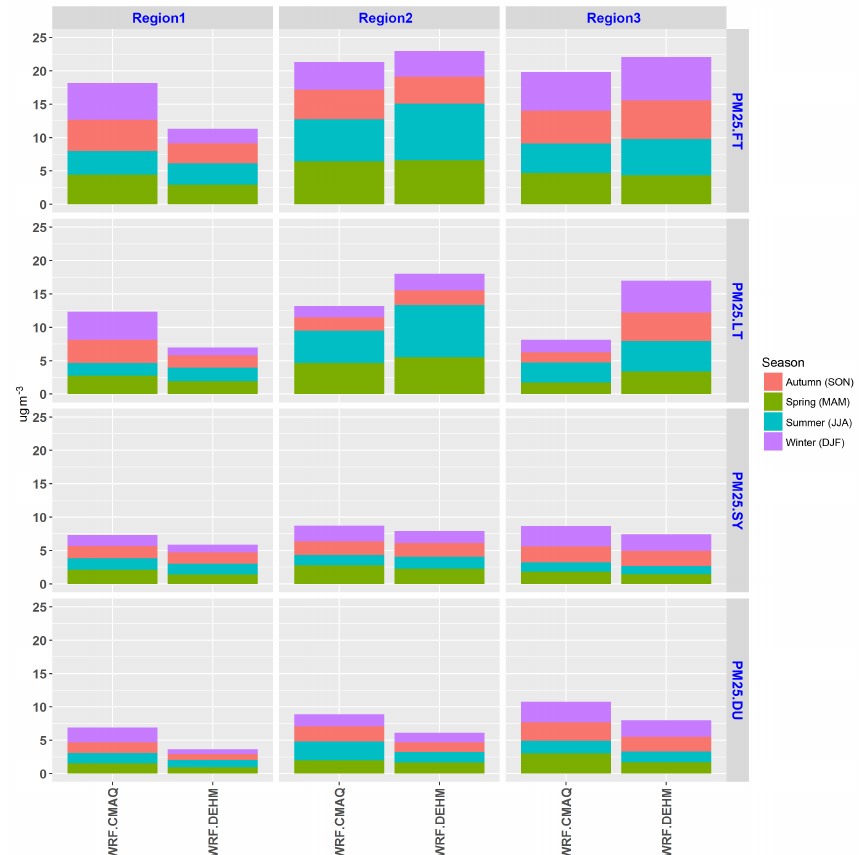
Figure 25. As in Fig. 9 but for PM 2 . 5 in North America (error units in µgm − 3 ) .